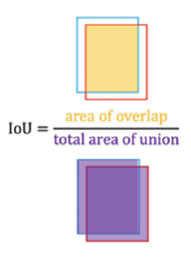
Figure 5. Intersection over union (IoU) is the division of the overlapping area by the total union area between the ground truth bounding box and the predicted one [28].